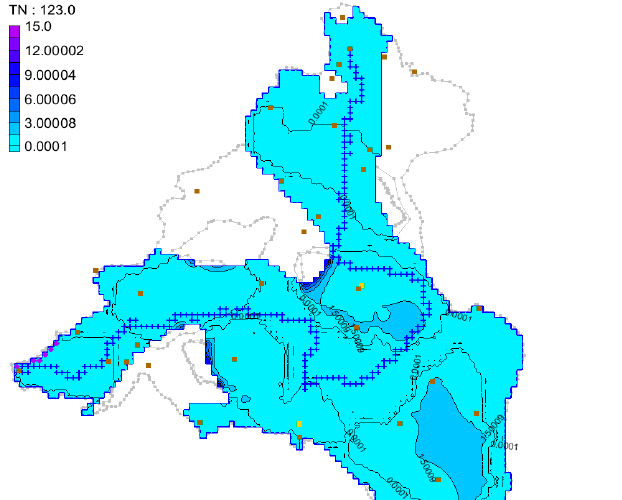
Figure 5. Scenario 1 model 1 of 23 d and 245 d total nitrogen simulation results.